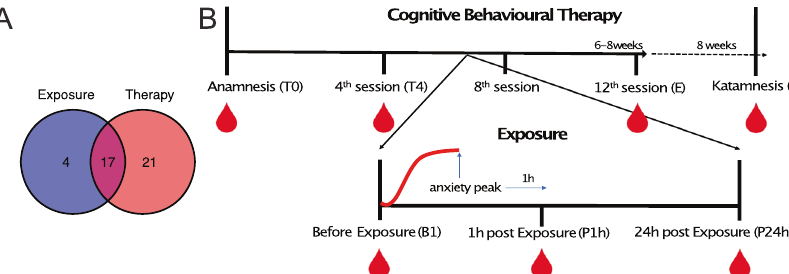
Fig. 1 Cohort, experimental procedure and data collection. A Cohort : Our study cohort comprised 42 patients. 21 were included in the therapy part only, 17 in both the exposure and therapy and 4 only in the exposure part. B Experimental procedure: Treatment consisted of 12 sessions of CBT (1 – 2 sessions per week, 6 – 8 weeks) as well as two booster sessions after 2 and 4 months. Therapy included two accompanied in vivo exposures (sessions 5,7) conducted outside the clinic in a feared situation.Therapy course related blood samples were collected before the treatment (T0), after the forth session (T4), at the end of therapy (E) and 2 months after the therapy (K). Additionally, 3 blood samples were collected during the fi rst exposure session (before the exposure basal (BE)), 1 h after the highest anxiety peak (post- exposure, P1h) and 24 h h after the exposure